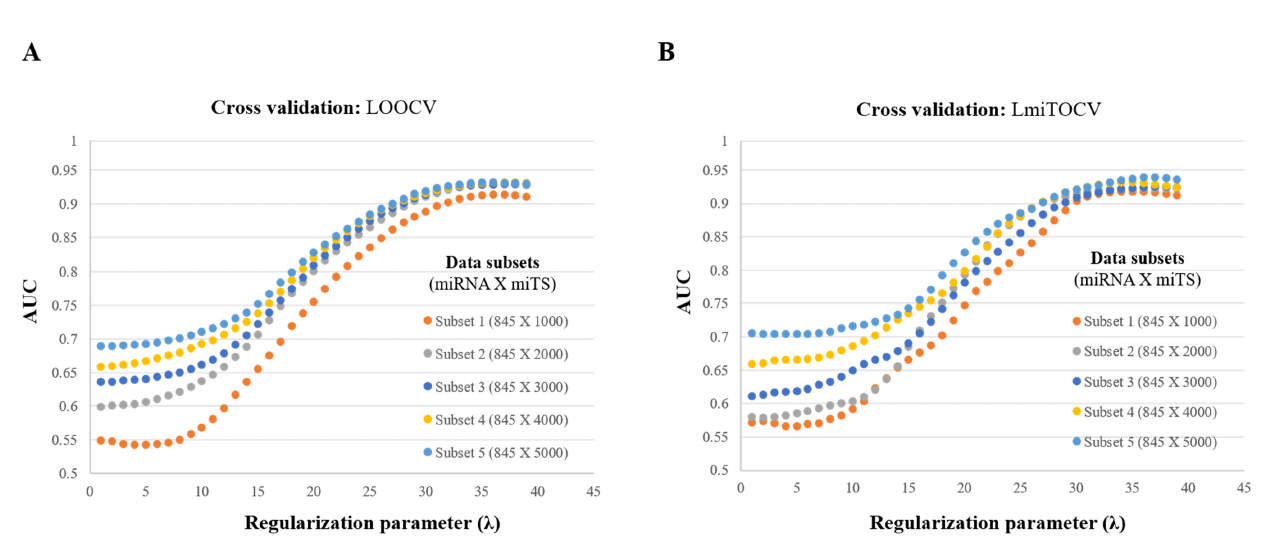
Figure A1. AUC measurement after simulating mintRULS model on different values of regularization parameter ( λ ). The randomization in case of each dataset was iterated over 100 times and average AUC was calculated in ( A ) LOOCV, and ( B ) LmiTOCV environment. Definitions: Subset 1 (845 X 100) contains a matrix representing interactions among 845 miRNAs and 1000 miTS; and similarly, for other subsets. Genes 2022 , 13 , x FOR PEER REVIEW